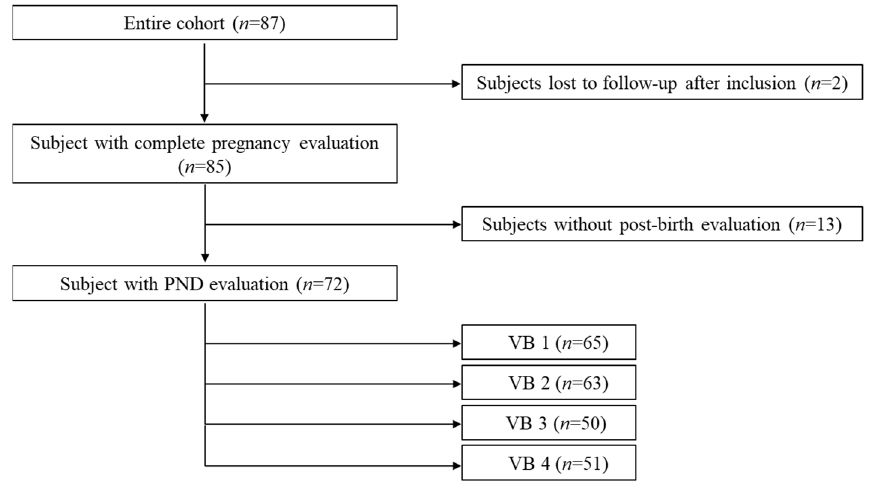
Figure 1. Flow diagram showing subpopulations within the initial cohort with the sample size at each of the four VB sessions. each of the four VB